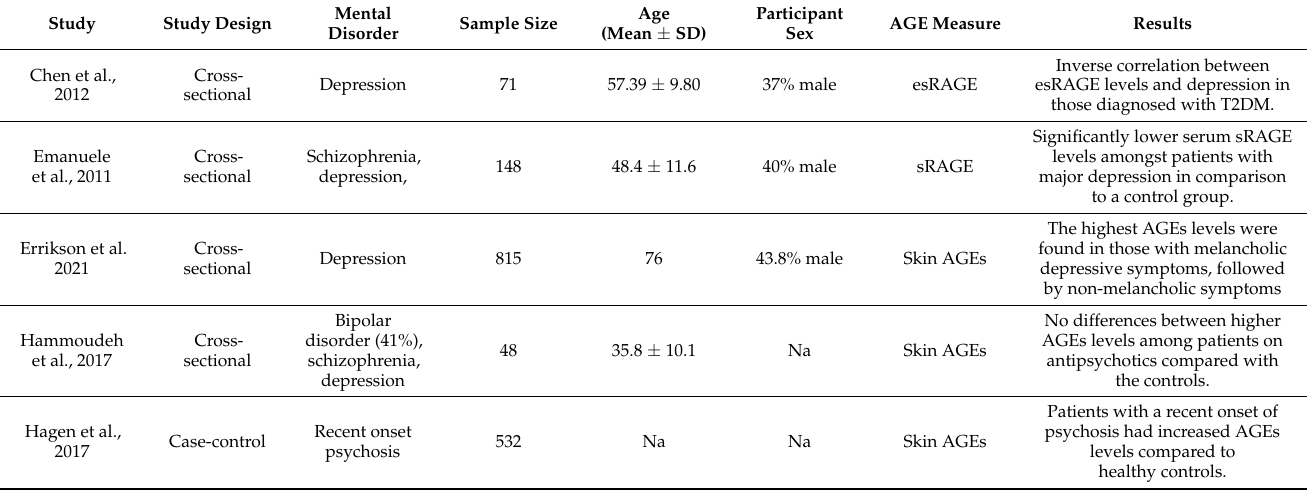
Table 2. Studies assessing the association between AGE concentrations and mental